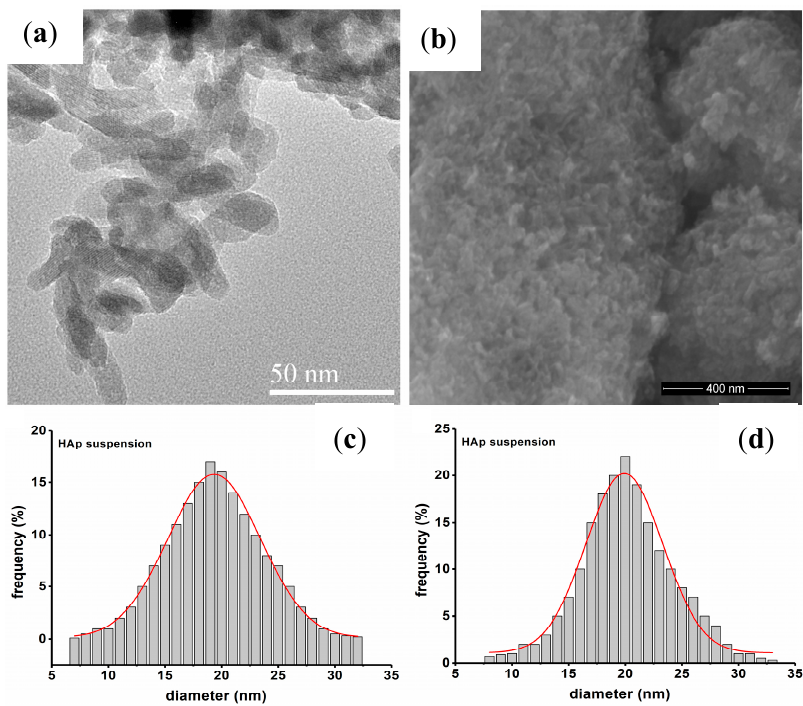
Figure 3. Transmission electron microscopy (TEM) ( a ) and scanning electron microscopy (SEM) ( b ) micrographs of HAp suspension. Particle size distribution of HAp suspension obtained by TEM ( c ) and SEM ( d ) studies.